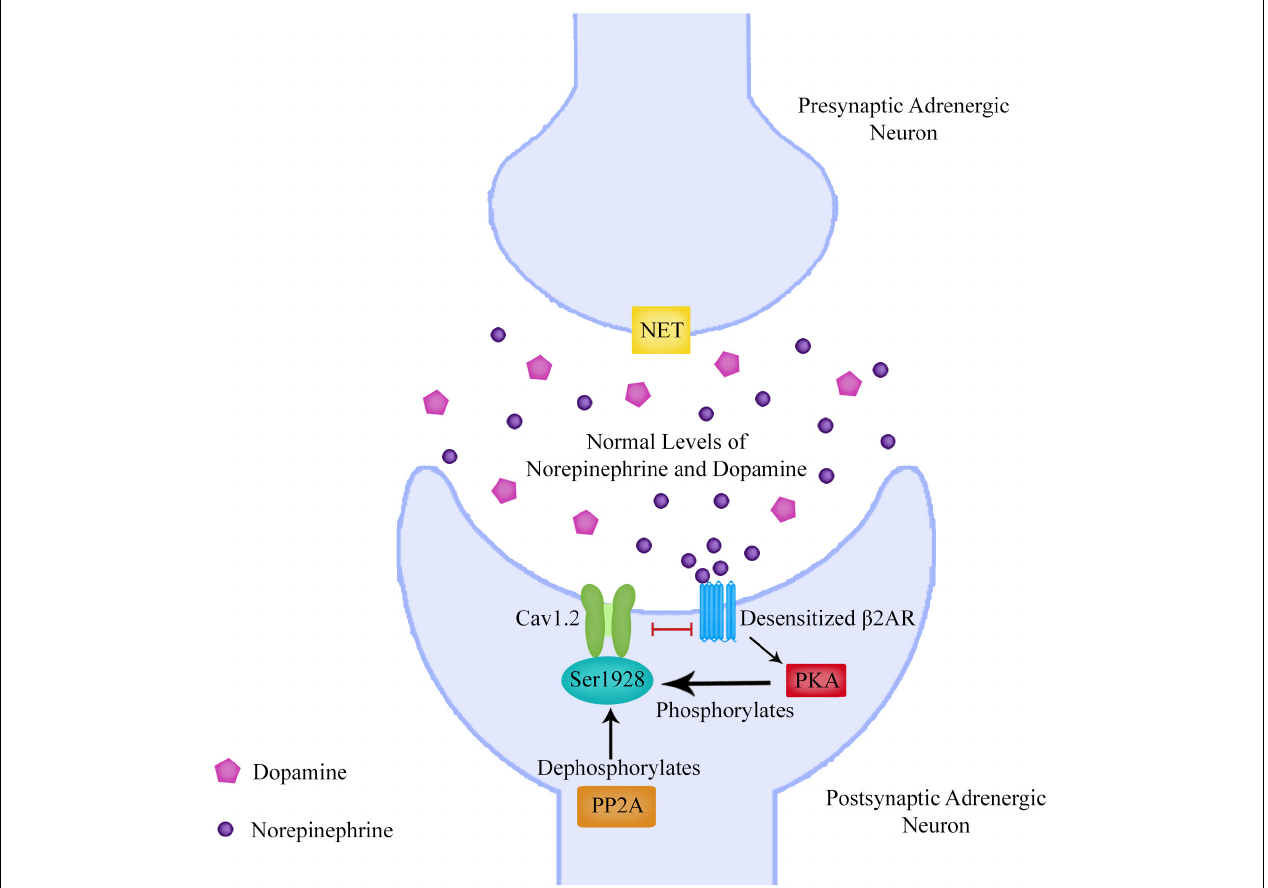
FIGURE 5 | The beta-2 adrenergic receptor ( β 2AR) can upregulate the L-type calcium channel Cav1.2 to allow calcium entry into the neuron. Protein Kinase A (PKA) phosphorylation of the Cav1.2 residue S1928 displaces the β 2AR from Cav1.2 upon β 2AR stimulation rendering Cav1.2 refractory for several minutes from further β 2AR stimulation. This desensitization process is an important mechanism to prevent cellular over-excitation. Protein phosphatase 2 (PP2A) is required for reversal of PKA-mediated Cav1.2 channel phosphorylation. This means that PKA as well as PP2A are important for Cav1.2 regulation by phosphorylation and dephosphorylation of Ser1928. As PP2A dephosphorylation of Ser1928 would result in reversing the displacement of Cav1.2 from β 2ARs, a dysregulation of PP2A could lead to the inability of β 2ARs to